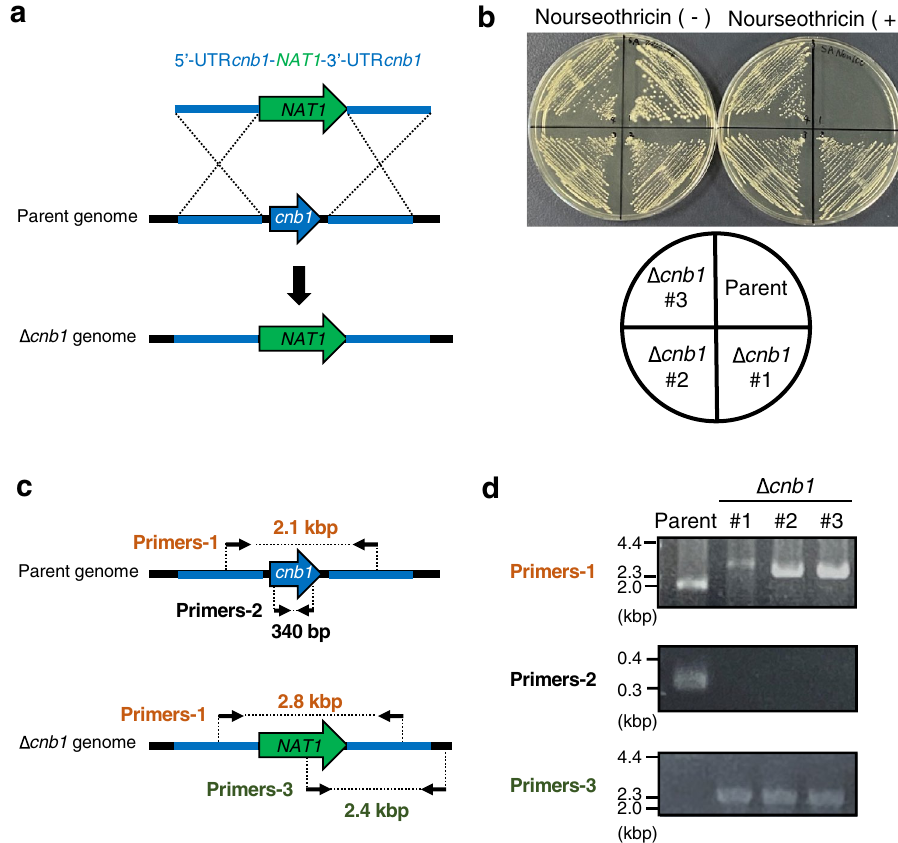
Figure 4. Construction of cnb1 gene-deficient mutant in the ku70 gene-deficient mutant of T. asahii MPU129 strain by electroporation. ( a ) Structure of the DNA fragment for construction of the cnb1 gene-deficient mutant and the predicted genome of the cnb1 gene-deficient mutant. ( b ) The parent strain (MPU129 ∆ ku70 ) and cnb1 gene-deficient candidates (∆ cnb1 #1, #2, and #3) were spread on Sabouraud agar medium with or without nourseothricin (100 µg/ml) and incubated at 27 °C for 2 days. ( c ) Location of the primers for confirming the genome structure of the cnb1 gene-deficient candidate by PCR. ( d ) Confirmation of the cnb1 gene-deficiency of the cnb1 gene-deficient candidate by PCR using extracted genome DNA. Cropped blots were used. Full-length blots are presented in Supplementary Fig. 1.